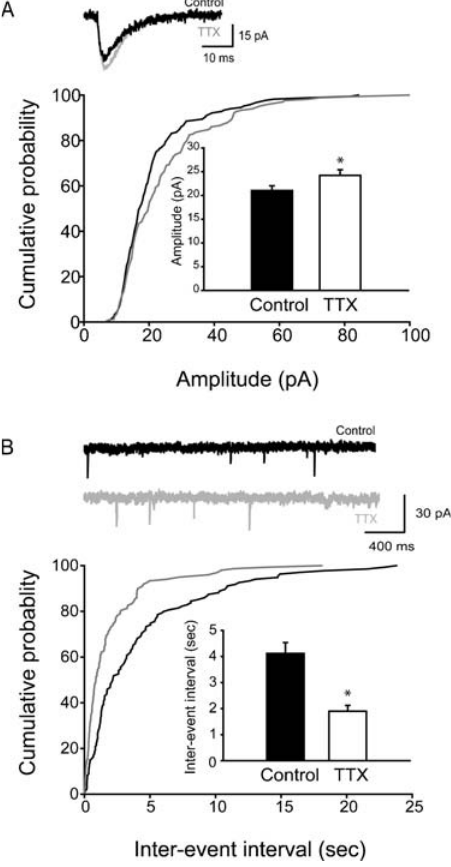
Figure 3. Increased amplitude and frequency of mEPSCs in juvenile CA1 cells after in vivo TTX-application. (A) Summary data of the mEPSC amplitudes; insert: representative averages from single cells. (B) Summary data of the inter-event interval of mEPSCs, with representa- tive traces as inserts.